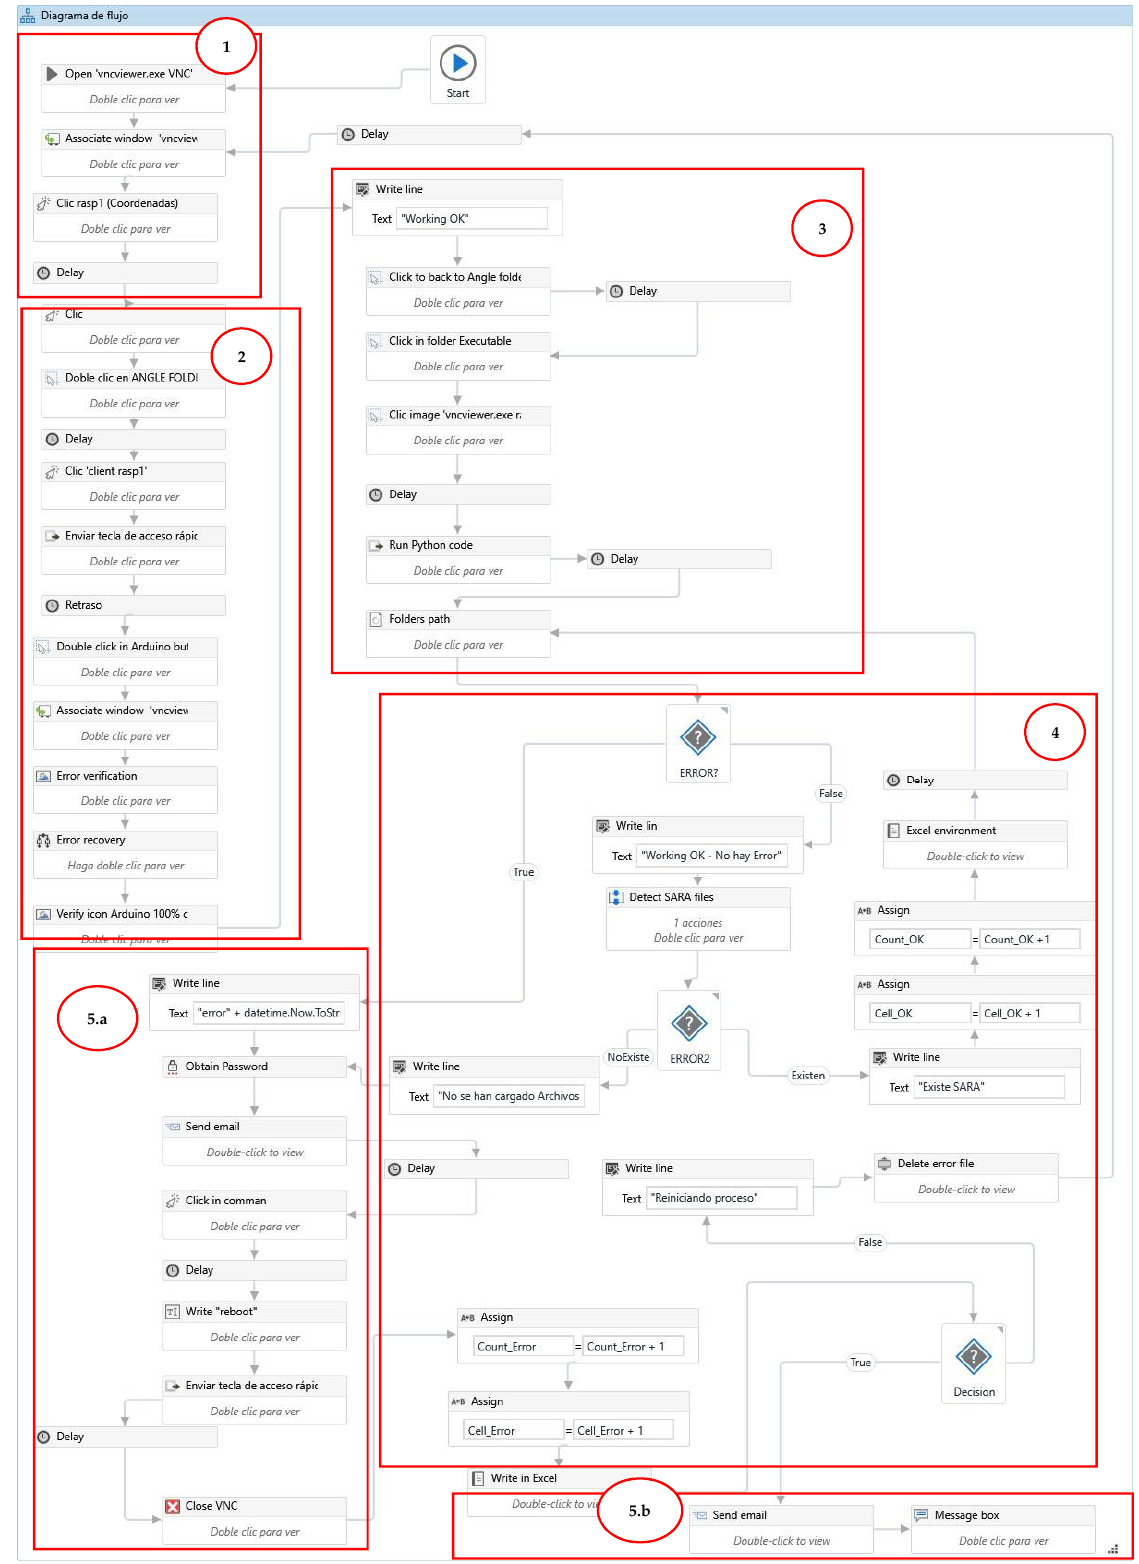
Figure 10 . RPA process diagram. Figure 10. RPA process